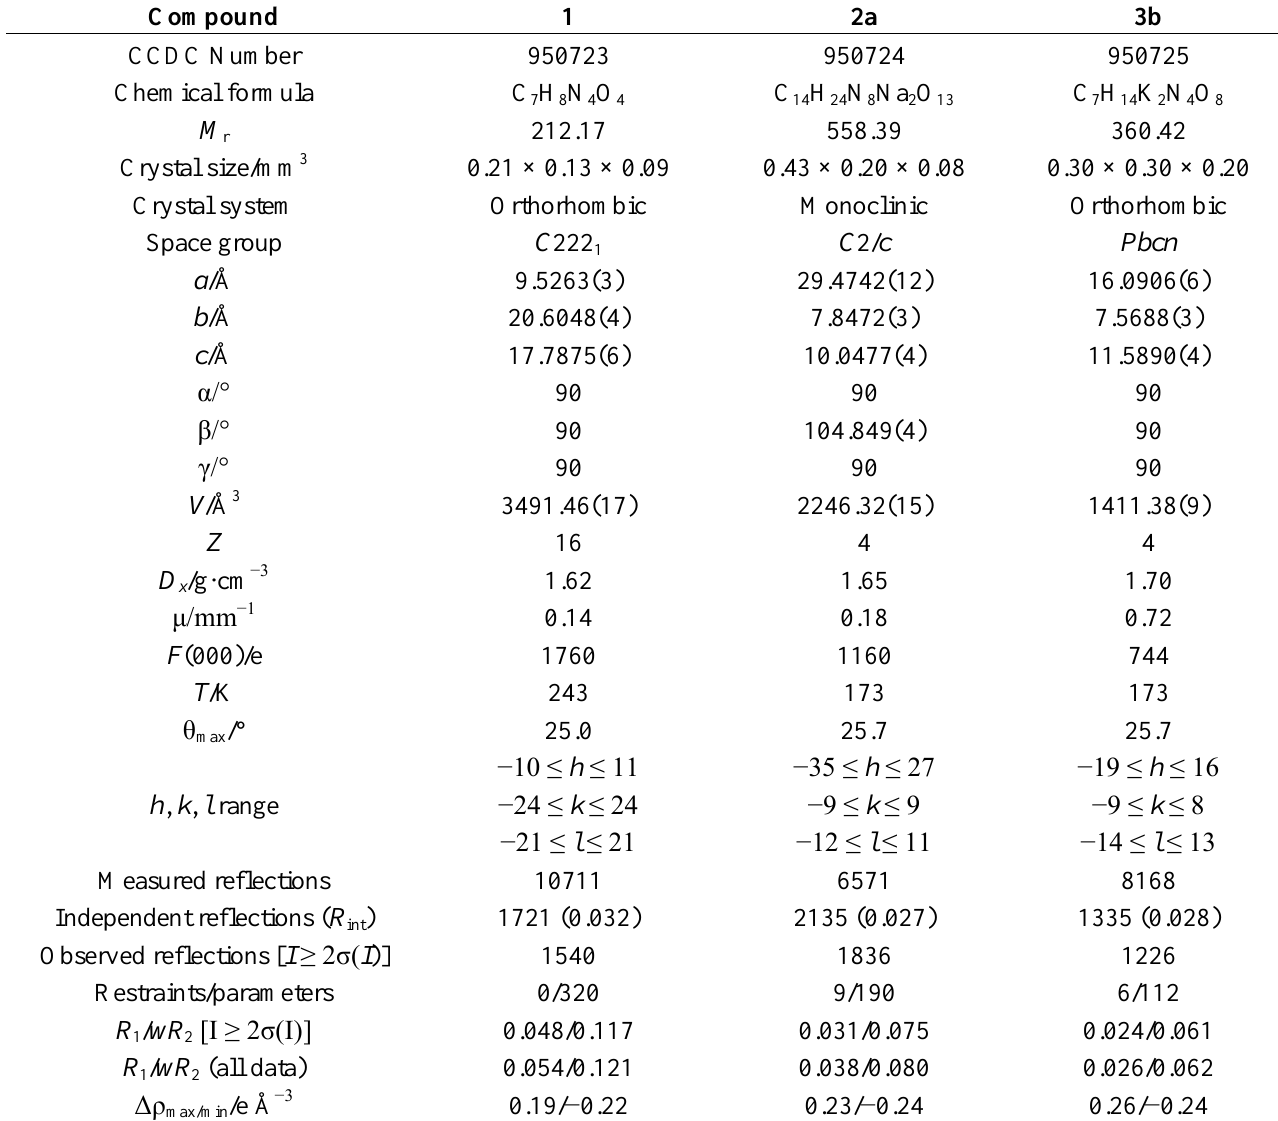
Table 1. Crystal data and structure refinement